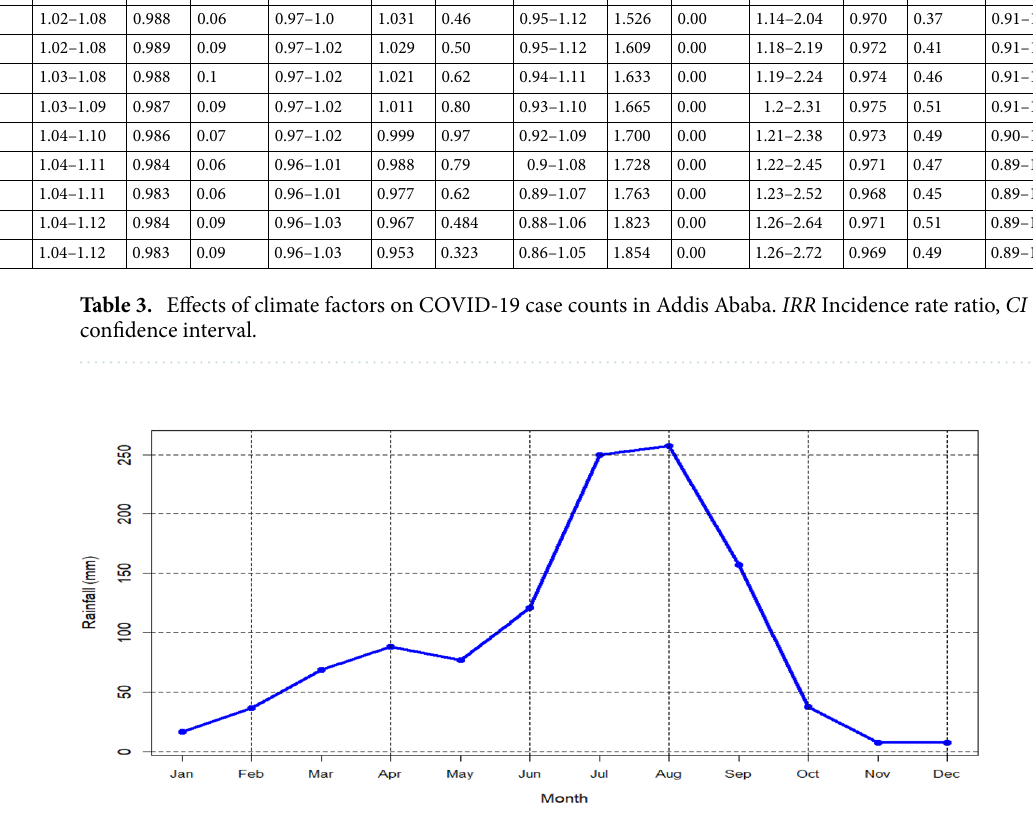
Figure 2. Rainfall climatology (1981–2010) of Addis